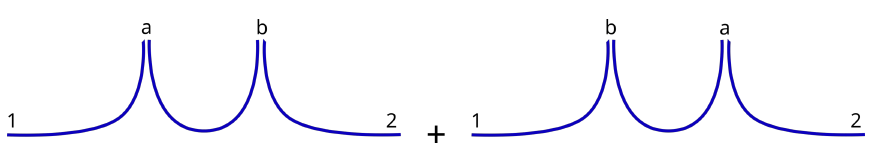
Figure 2 . The large- N c colour-flow decomposition of the double real squared